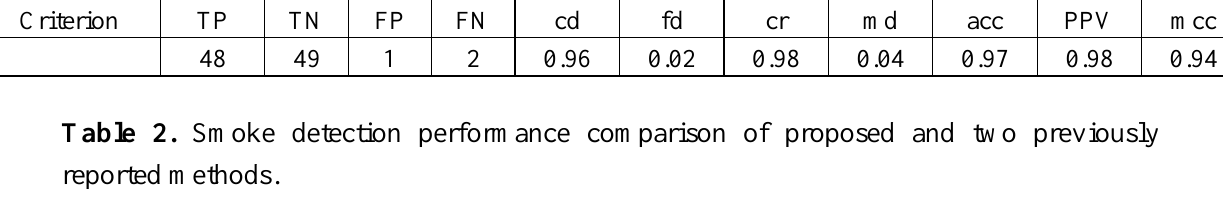
Table 1. Evaluation results of proposed algorithm using global evaluation measures.